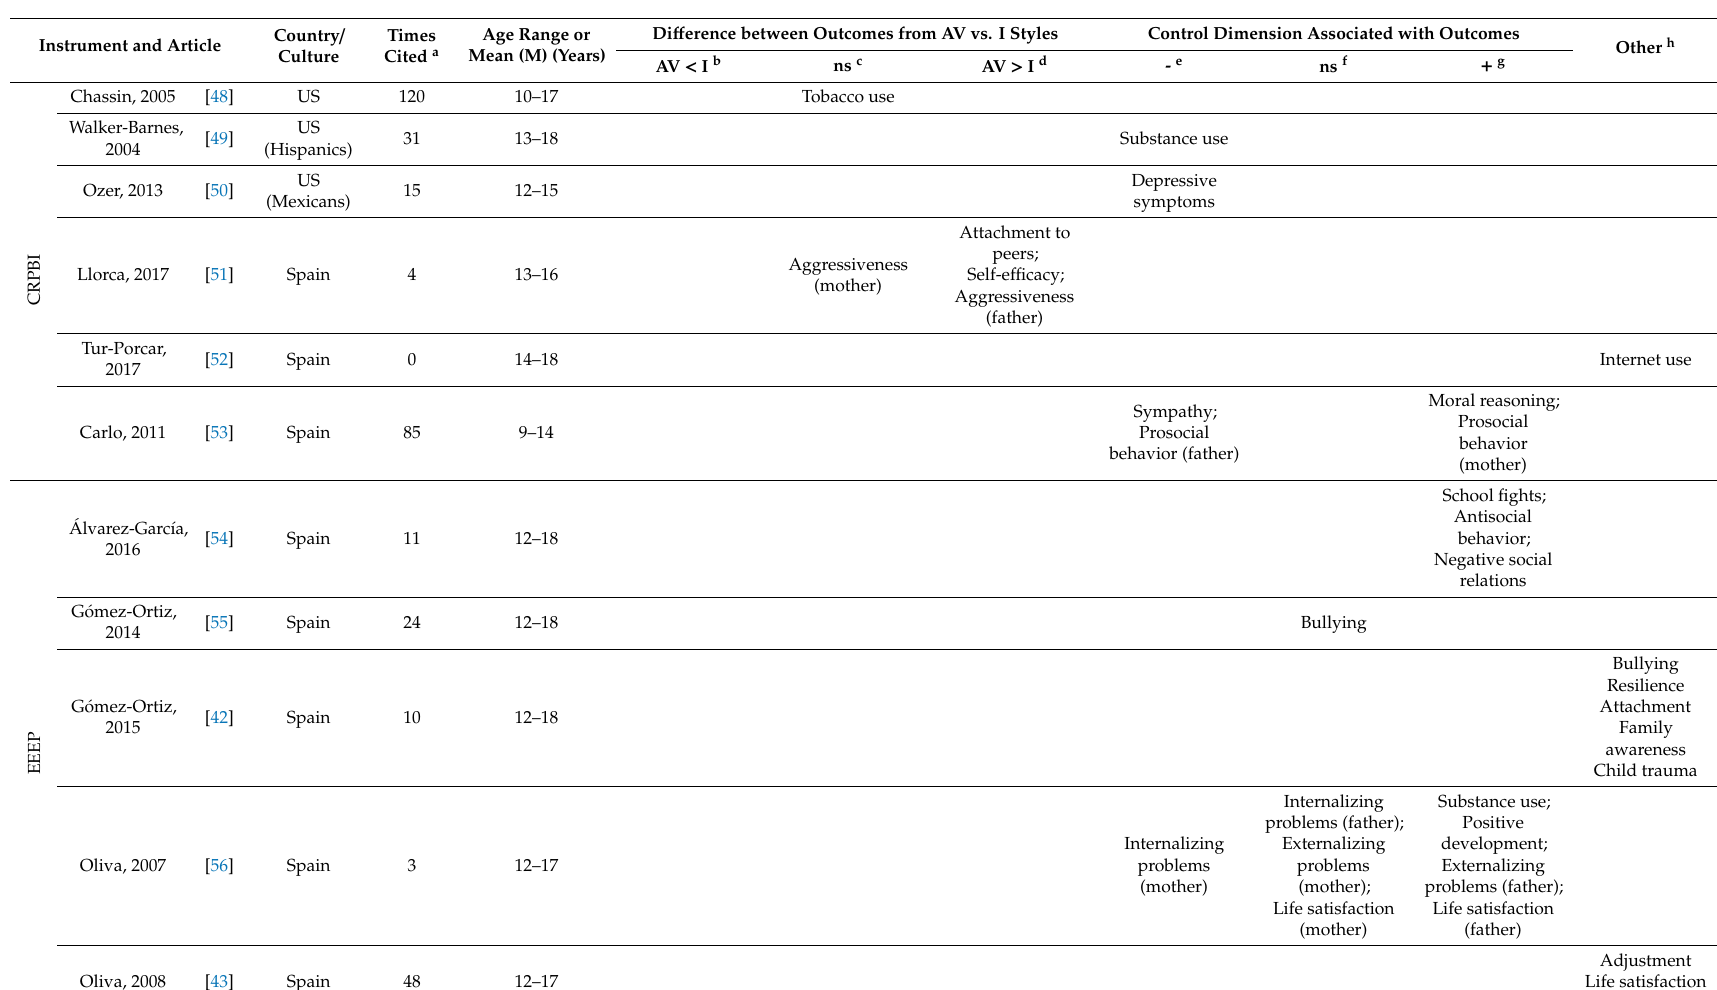
Table 4. Detailed associations between control and